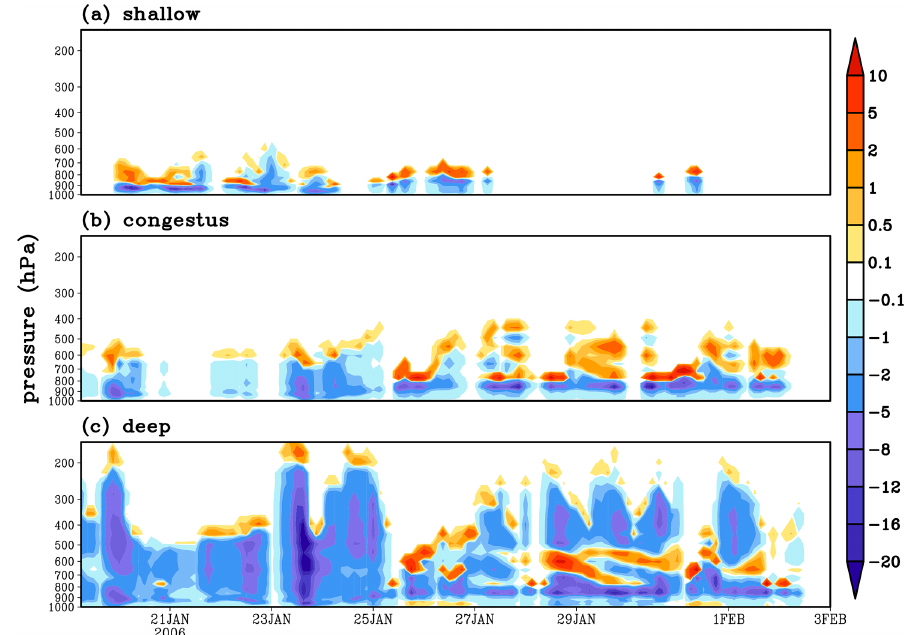
Figure 6. Convective drying tendencies (gkg − 1 d − 1 ) of (a) shallow, (b) congestus, and (c) deep convection with the GF scheme using the TWP-ICE